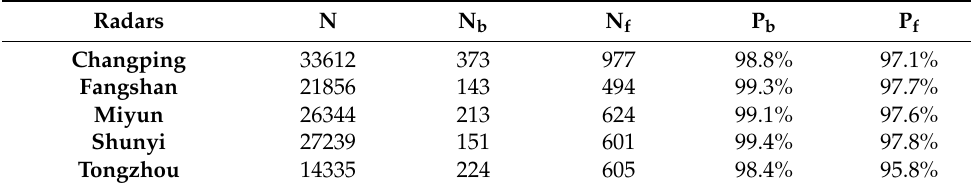
Table 2. The effect of CAT echo recognition and elimination.